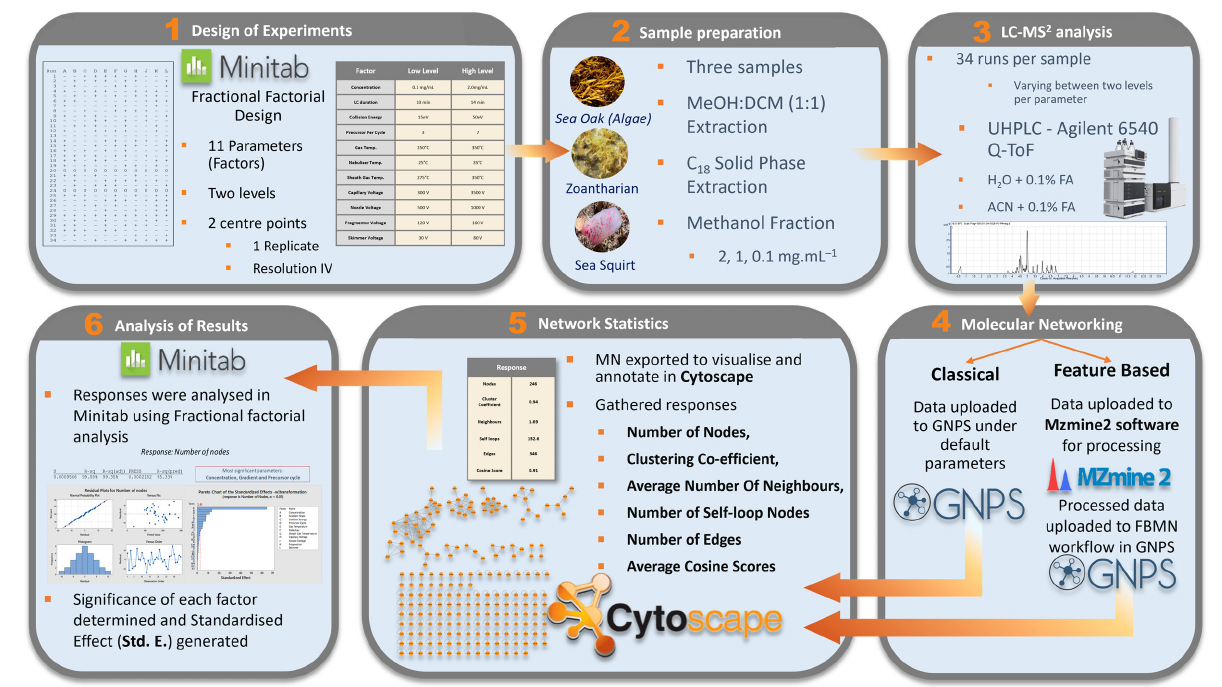
Figure 13. Workflow for evaluating the effect of data acquisition parameters on molecular network topology. Minitab fractional factorial design was used to design an experiment to determine whether a given parameter (factor) significantly affects molecular network topology. Samples were extracted with Methanol: Dichloromethane (1:1) and fractionated on a C 18 SPE cartridge. A methanolic fraction of each sample was analysed 34 times on a UHPLC-Agilent 6540 q-TOF using unique parameter setting for each analysis. Each parameter had a high and low setting. Molecular networks were generated from untargeted LC-MS 2 data using both the Classical and Feature-Based workflows offered by the GNPS online platform. Data pre-processing for the FBMN workflow was completed using MZmine 2. Molecular networks from both workflows were vizualised in Cytoscape and responses were analysed in Minitab fractional factorial analysis to determine the Standardised Effect (Std. E.) of each